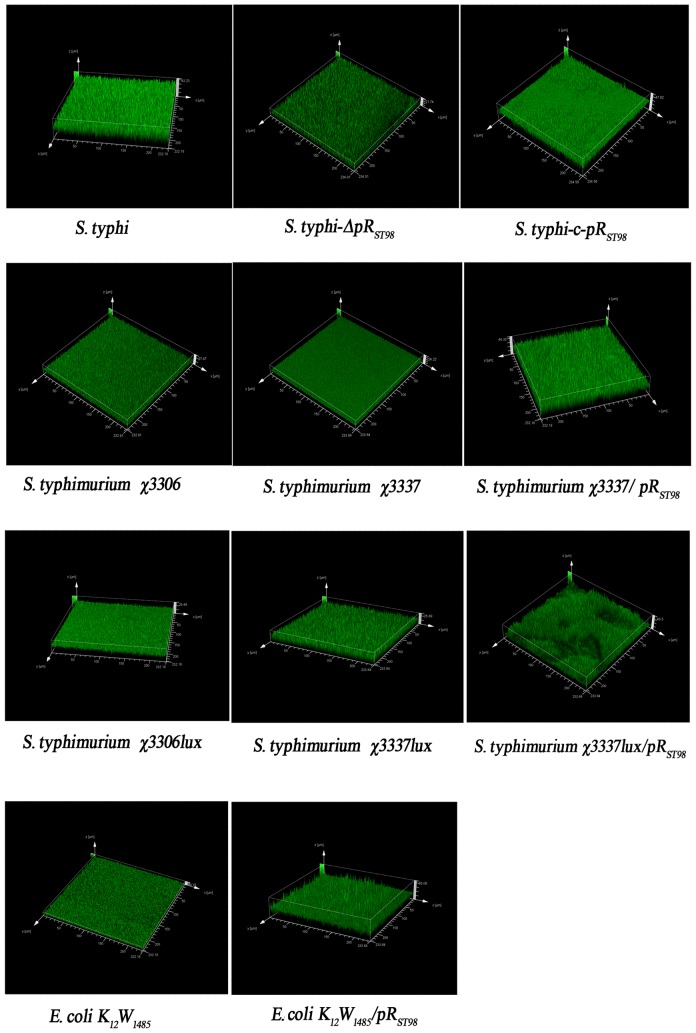
Quantification of BF by CLSM.Different bacteria were cultured in 24-well plates for 3 d, and the developed pellicles were harvested, placed on glass slides, and subjected to 3D image reconstruction by CLSM.